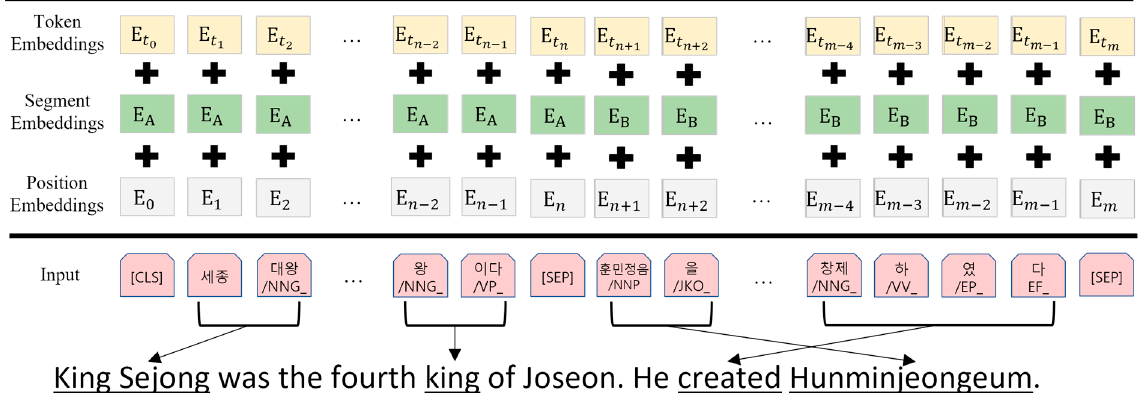
Figure 4. Example of input for Korean BERT model.